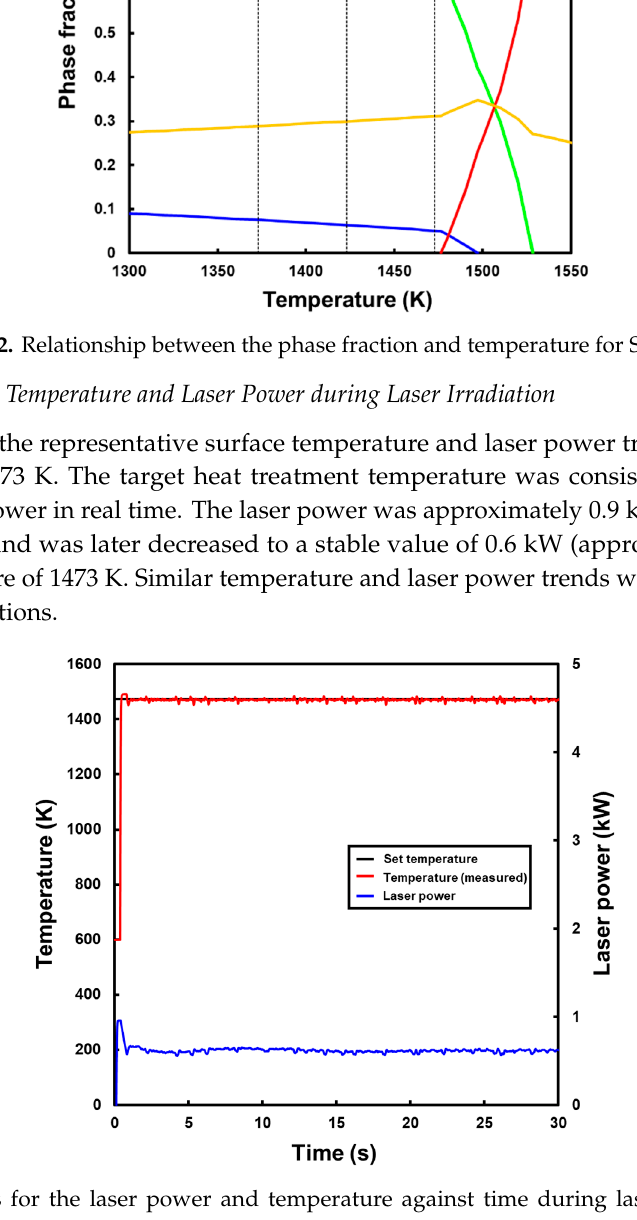
Figure 3. Trends for the laser power and temperature against time during laser heat treatment (set temperature: 1473 K).